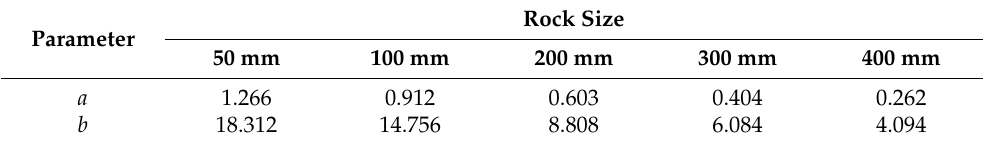
Table 7. Values of parameters a and b .